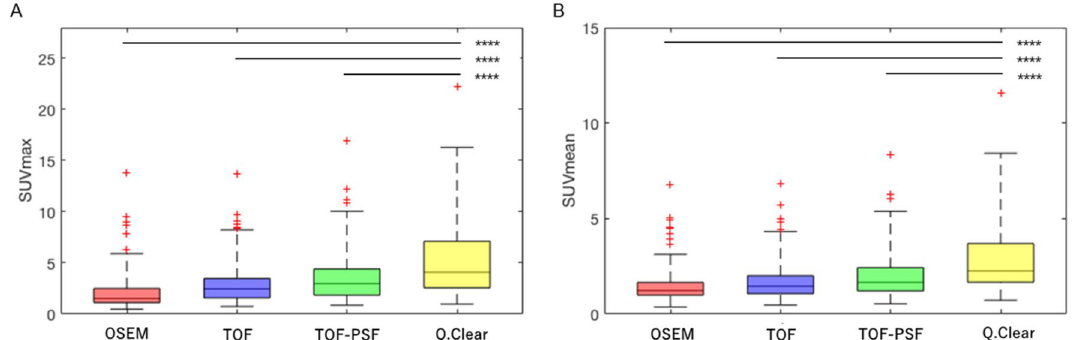
Figure 4. The box plots of ( A ) SUVmax and ( B ) SUVmean measurements of 75 pulmonary nodules on PET images reconstructed with different methods. Highly statistically significant differences (noted as ****P values < 0.001) in the SUVmax and SUVmean were shown between PET images reconstructed with Q.Clear and each of the other 3 methods (OSEM, TOF, and